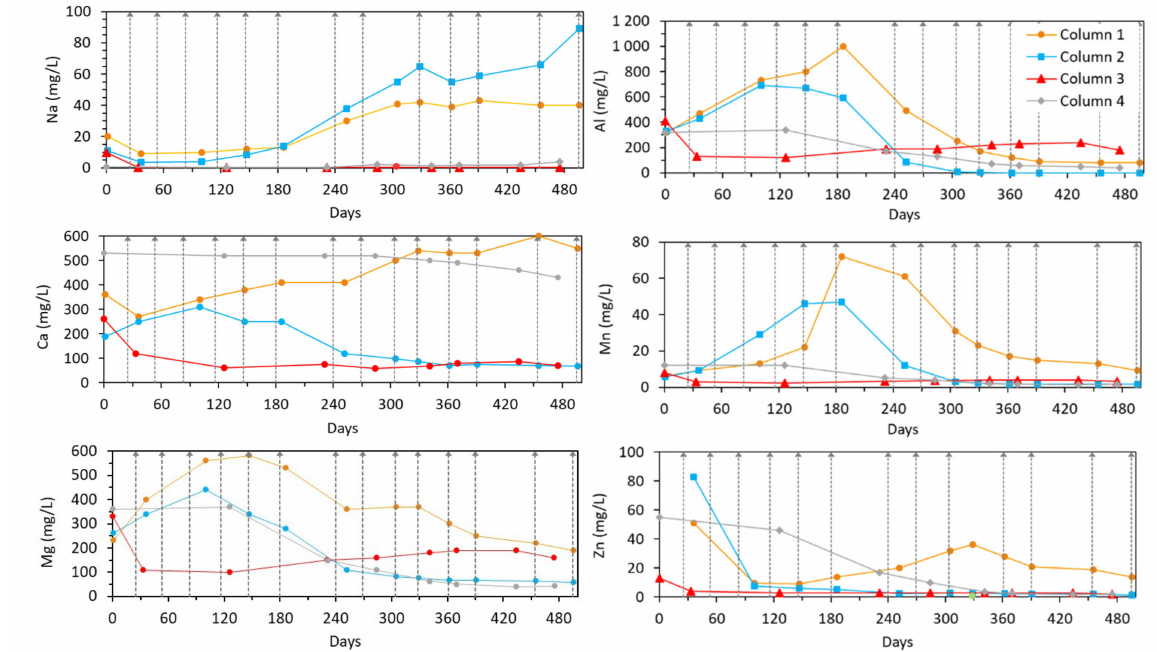
Figure 10. Concentrations of Na, Ca, Mg, Al, Mn, and Zn, as a function of time, in the column leachates. Vertical dashed lines mark the beginning of each wetting-drying